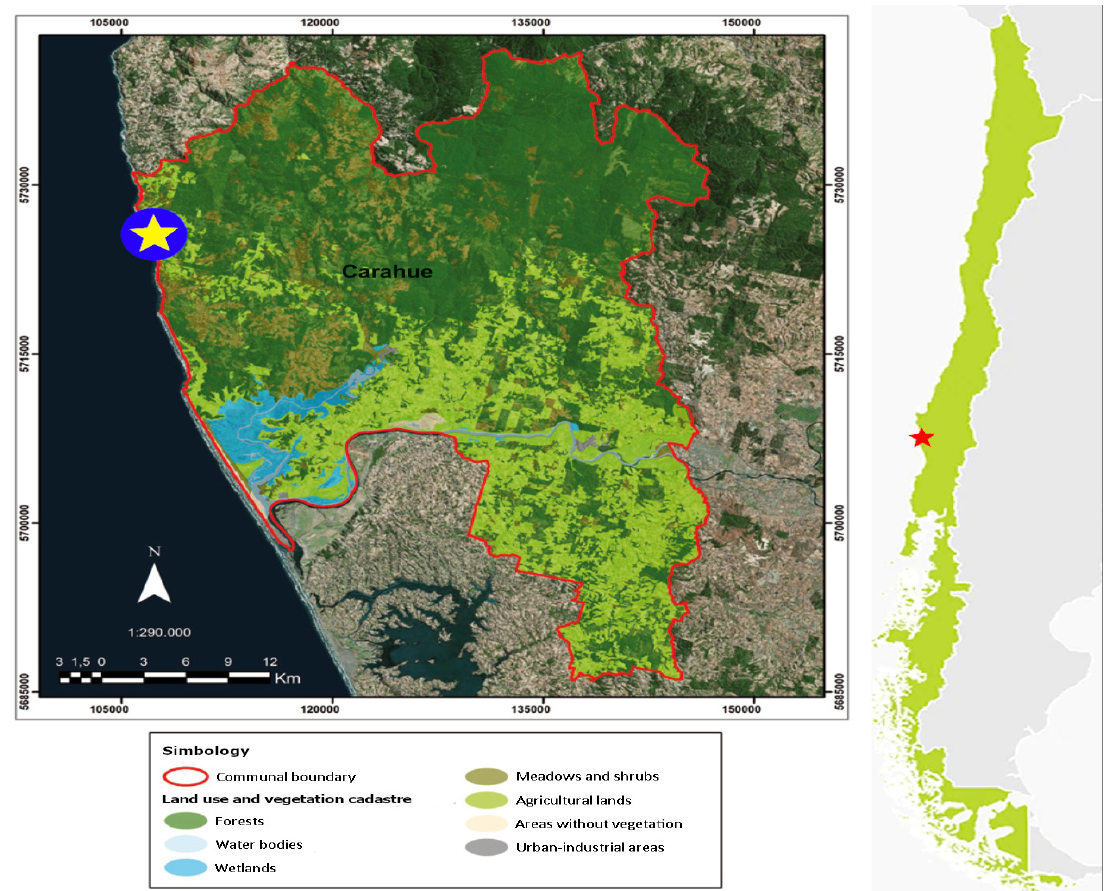
Figure 3. Location of the José Painecura Hueñalihuen community